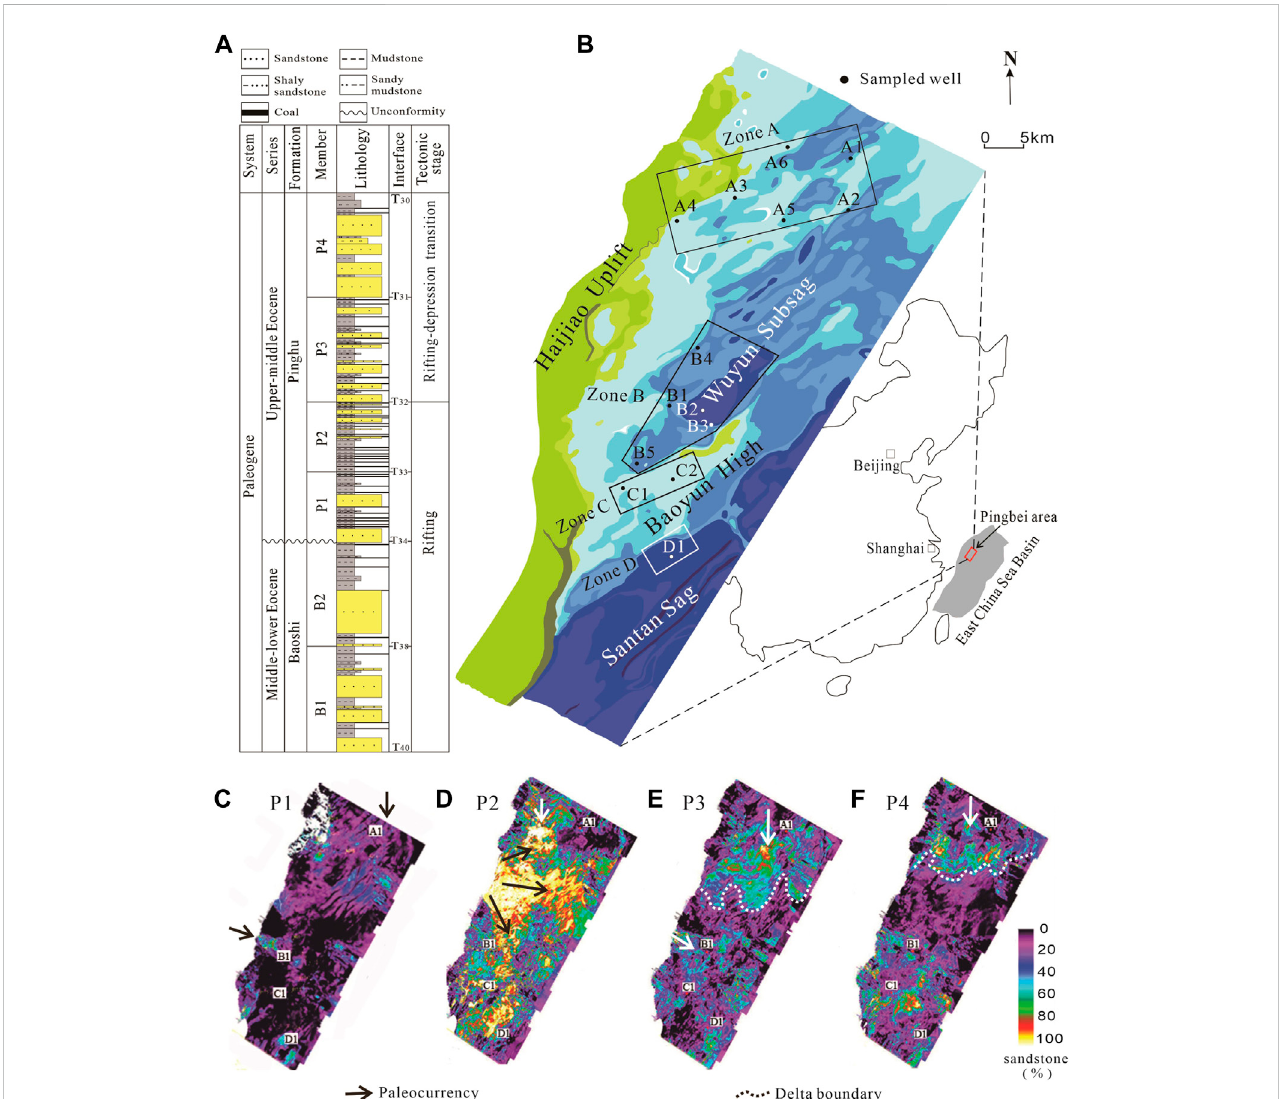
Generalized stratigraphy of the Pinghu Formation (A) , the paleogeomorphology at the bottom of P1 Member [ (B) , modi fi ed from Li et al., 2019), the sandstone percentages(including siltstone,obtained byseismicinversion] intheP1 (C) ,P2 (D) , P3 (E) and P4 (F) members inthePingbei areainthe EastChina Sea